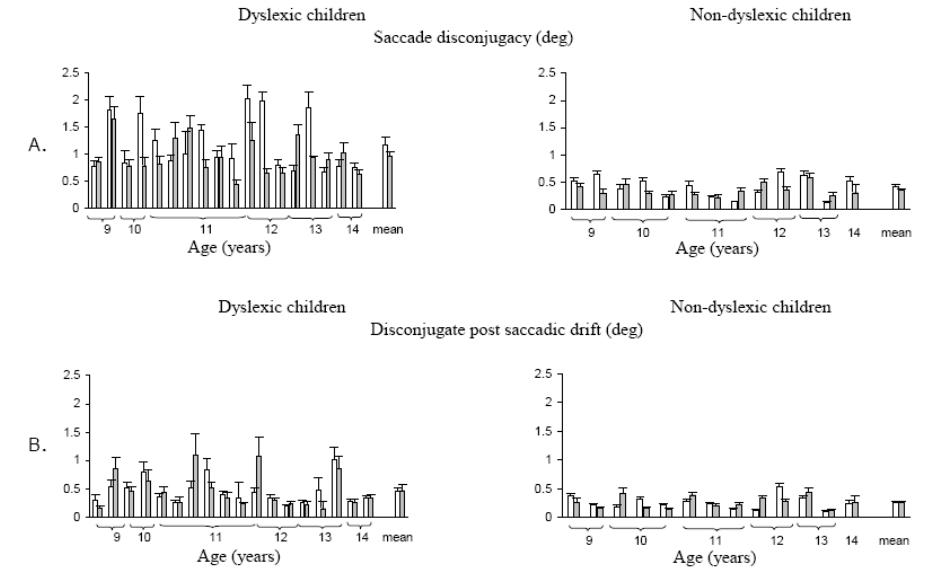
Figure 6. Individual average disconjugacy of saccades in degrees (A) and individual average disconjugate post saccadic drift in degrees (B) measured during reading of single words and during saccades to the LED for dyslexic and non-dyslexic children.